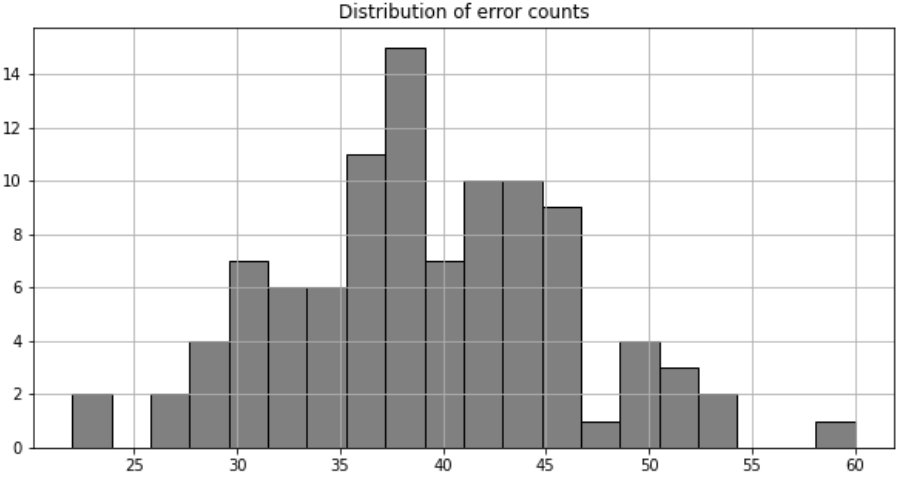
Figure 8. Distribution of error